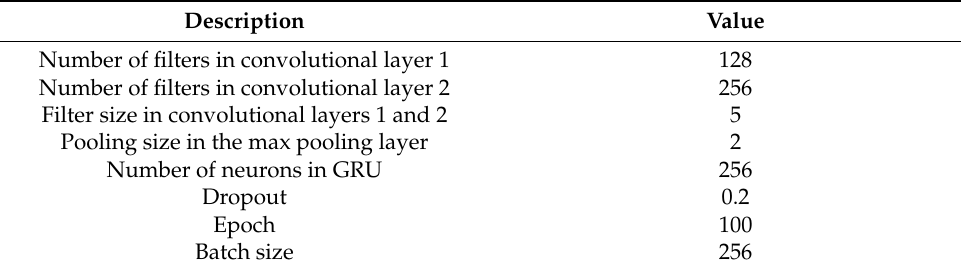
Table 5. Parameters in the diagnosis model of depression.